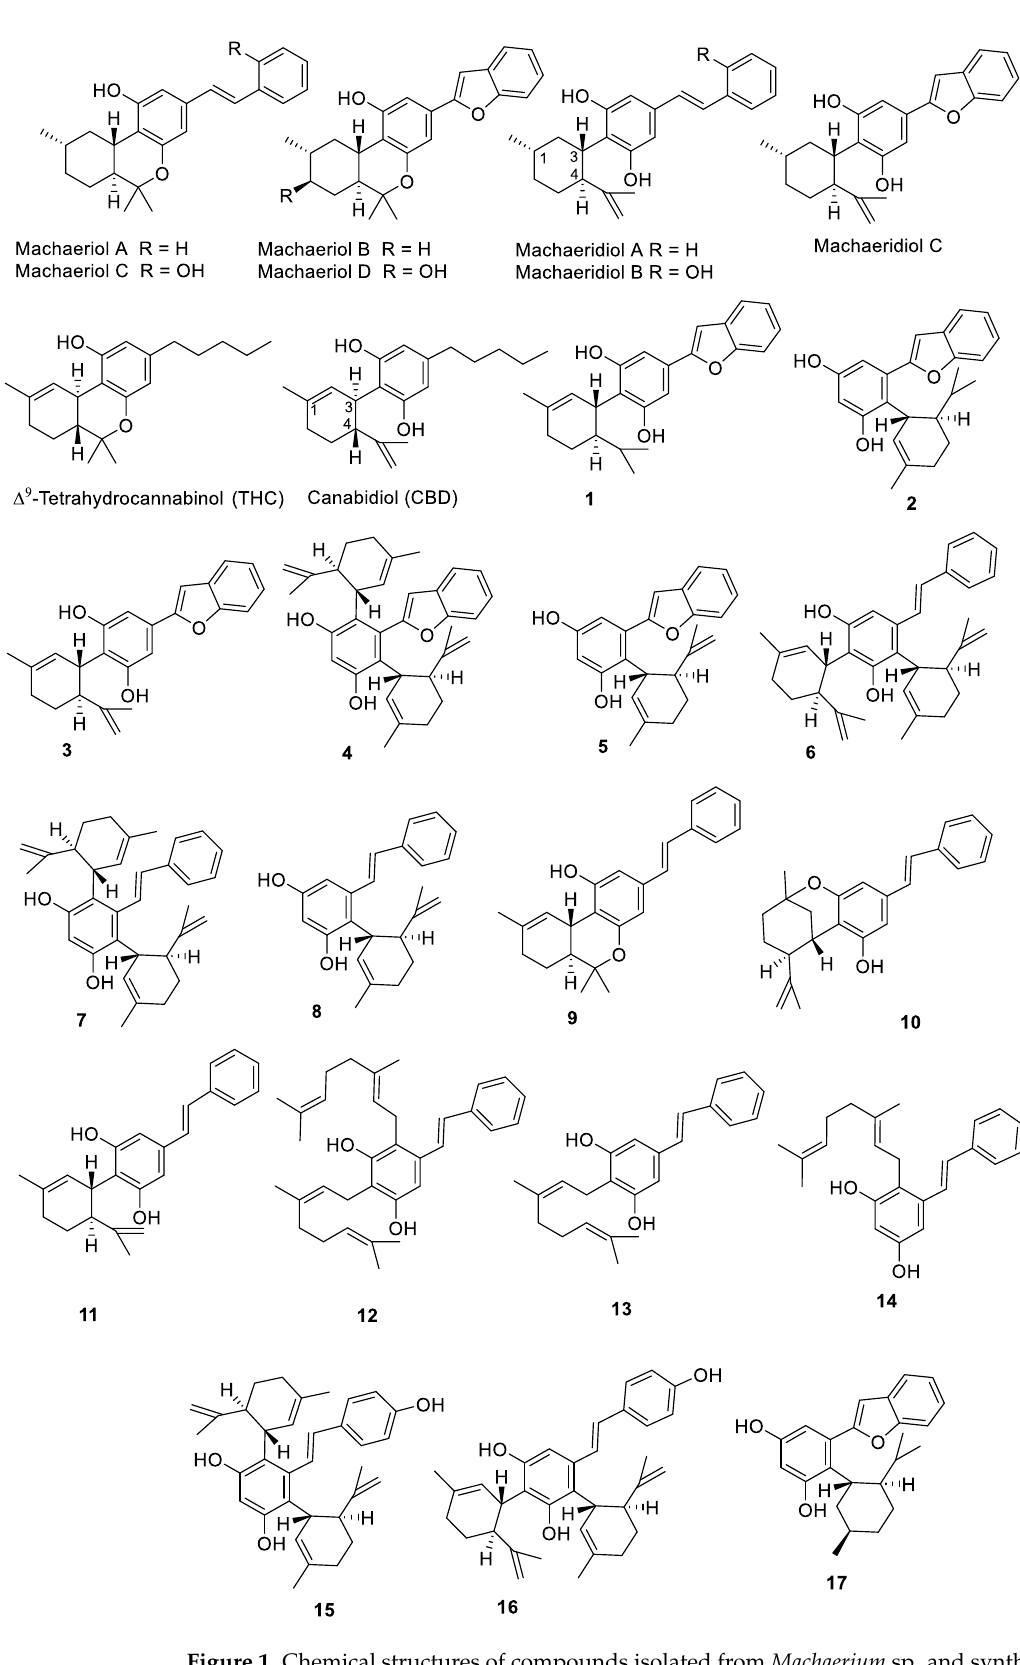
Figure 1. Chemical structures of compounds isolated from Machaerium sp. and synthetic analogs.